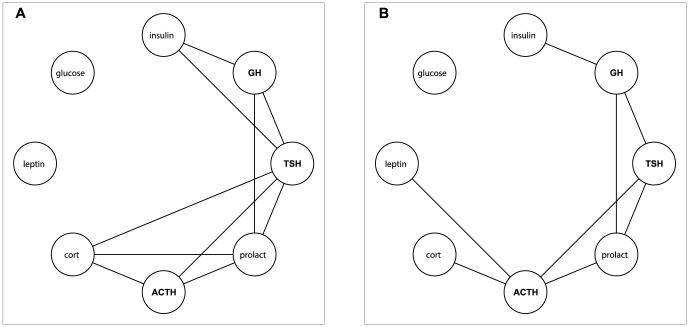
Correlation A and partial correlation B hormone networks.The significant links show a high degree of overlap between the correlation and the partial correlation networks.